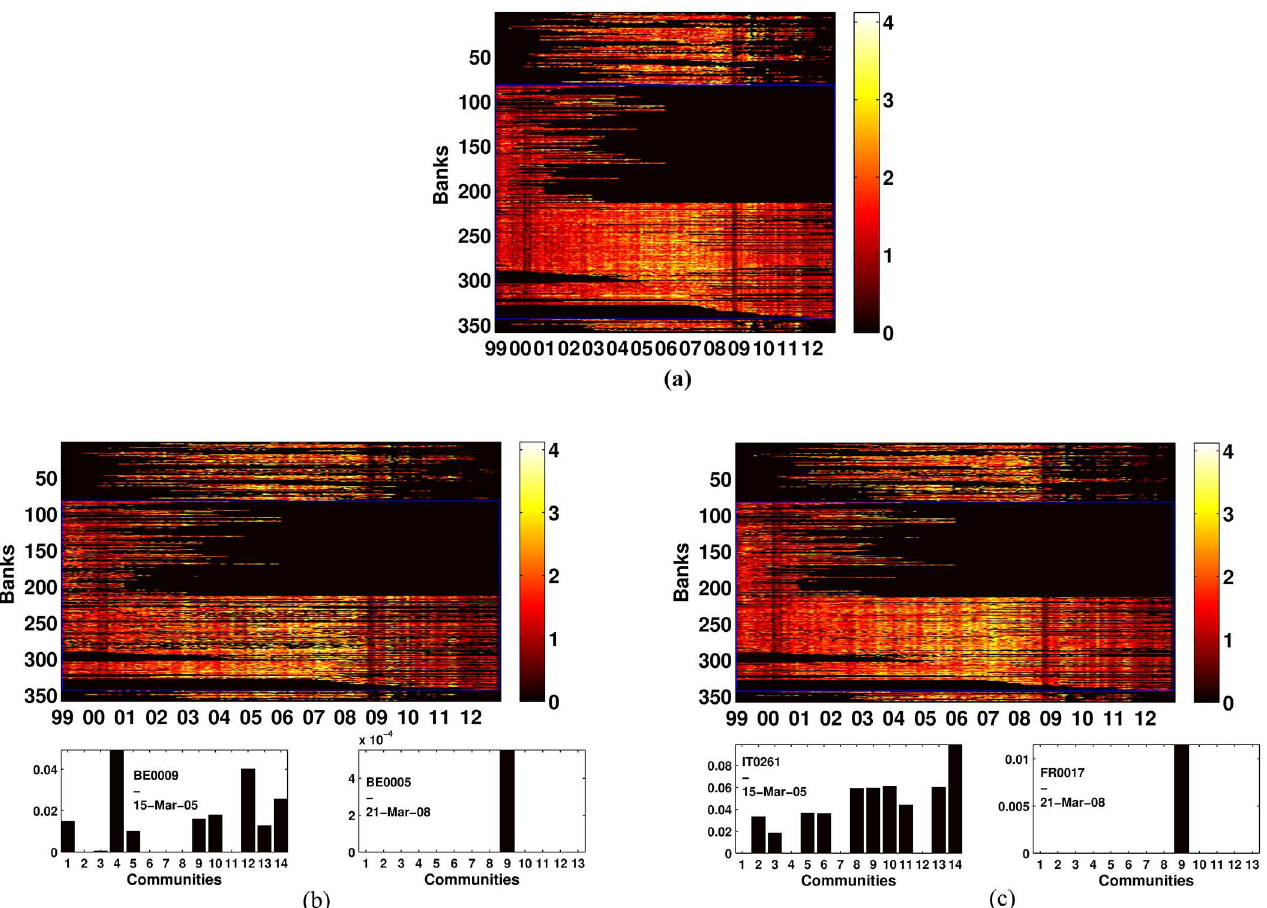
Fig 3. Time evolution of the coefficient of variation. Time evolutionof the coefficient of variationof the membership distribution(a) and for the borrowing (b) and the lending (c) scores. We distinguishbetweenItalian and foreign banks behavior encapsulating Italian banks into a blue rectangle. In each subplotthe y-left axis shows the number of anonymous banks operatingwhile the x-axis denotesyears. The color bars emphasize the coefficientof variationvalue. The bottom panels show an exampleof the degreemembershipdistributionassociated with banks in particular periods:it can be dispersedacross communitiesor fully concentrated into a